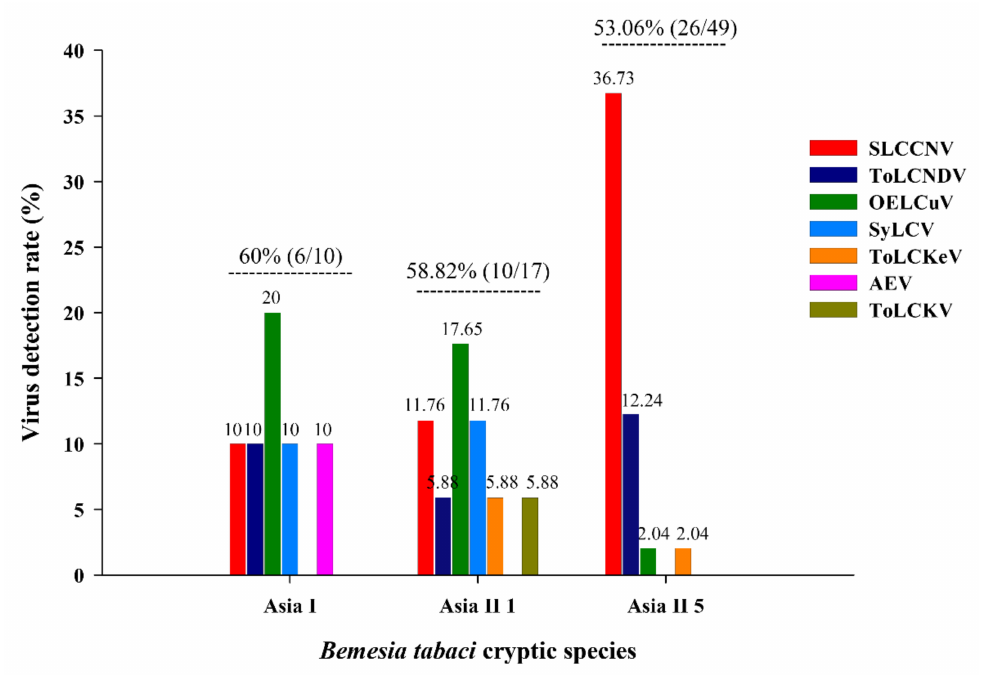
Figure 4. Detection rates of different begomoviruses from three cryptic species of Bemisia tabaci in